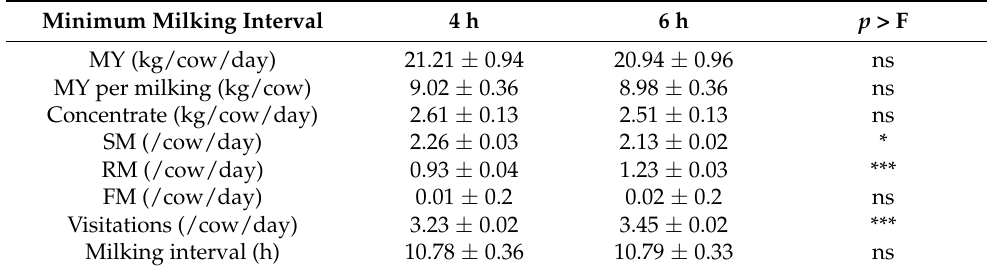
Table 4. Comparison of zootechnical performance according to the length of minimum milking interval (MMI).